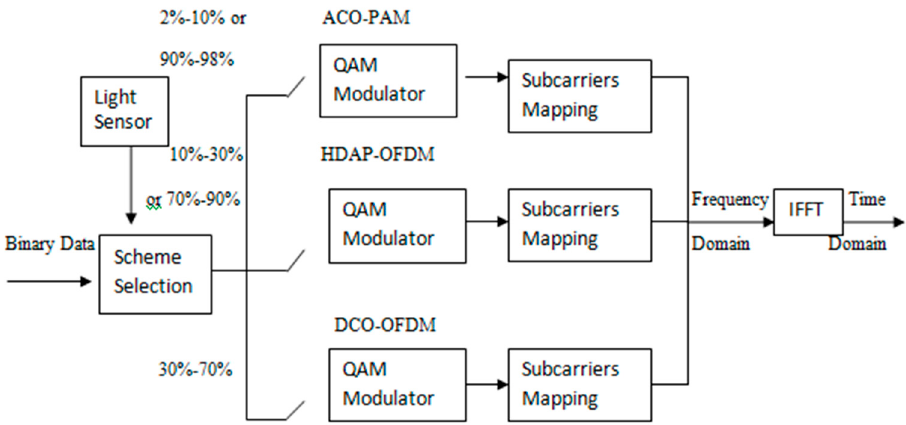
Figure 11. Block Diagram of the transmitter part for switching between different components of hybrid DC biased asymmetrically clipped pulse amplitude modulated discrete multitone modulation optical OFDM (HDAP-OFDM), where OFDM stands for orthogonal frequency division multi- plexing.